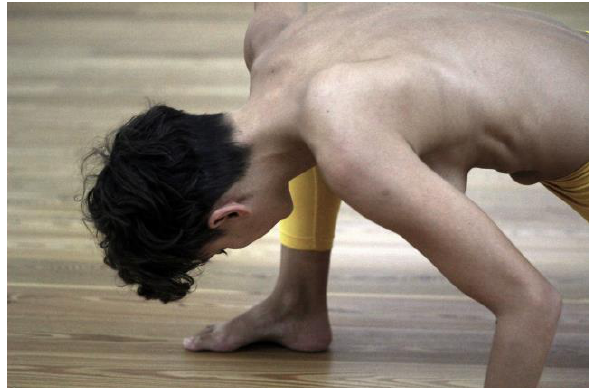
Figure 3 | Photo by José